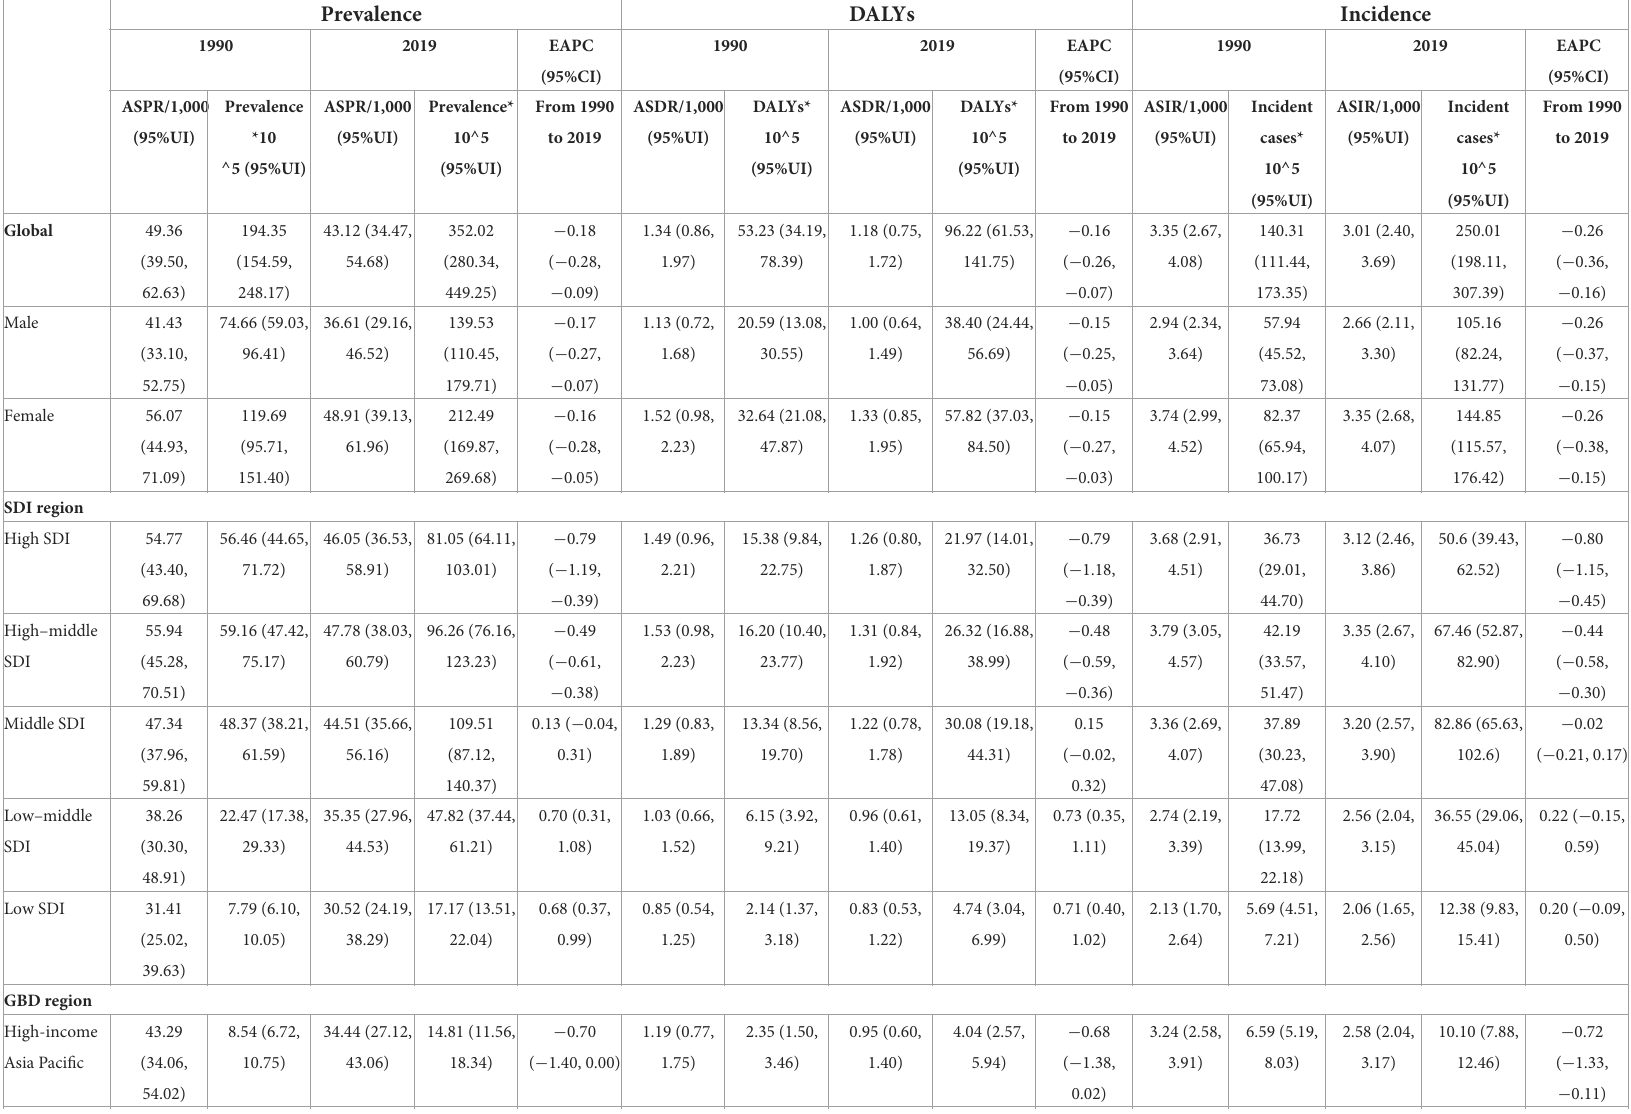
TABLE 1 Prevalence, DALYs, incidence and age-standardized rate per 1,000 people for edentulism in 1990 and 2019, and its estimated annual percentage change from 1990 to